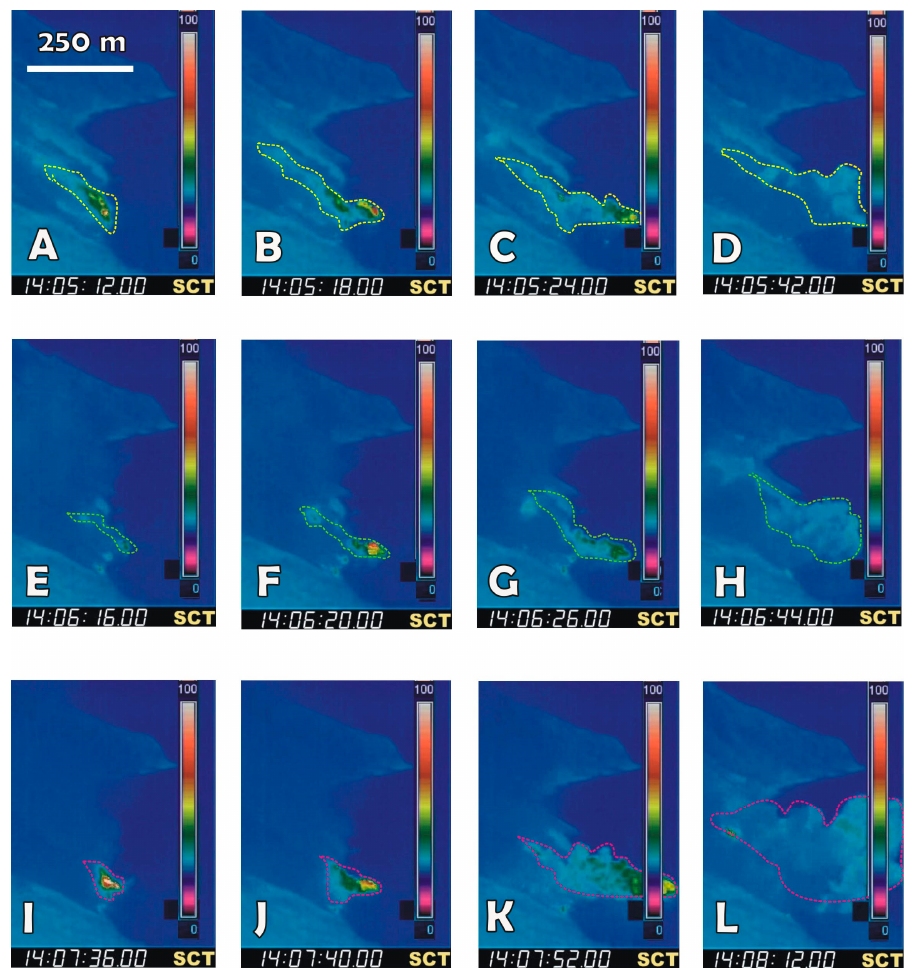
Figure 6. Thermal images recorded by the SCT camera located at Labronzo, ~100 m a.s.l. (see Figure 1b for location), showing the hot “gravel flows” that reached the sea on 6 August 2014, at 14:05 ( A – D ), 14:06 ( E – H ) and 14:07 ( I – L ), spreading on the sea surface. Temperature is in °C. The velocities of the three landslides of hot blocks in the frontal region were 9.8 m s − 1 , 5.9 m s − 1 and 9.8 m s − 1 , respectively, based on web-cameras